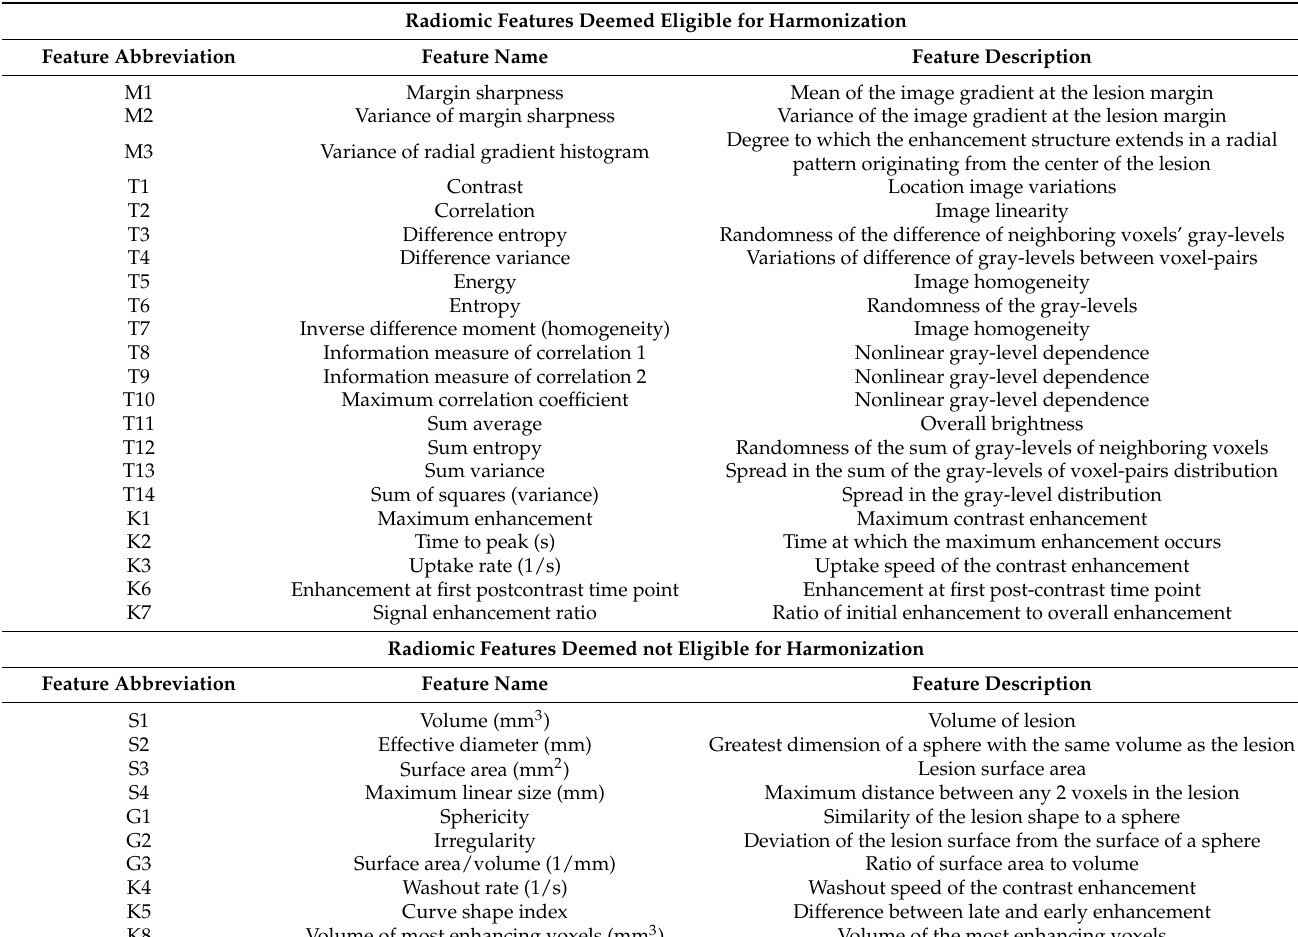
Table 2. Description of radiomic